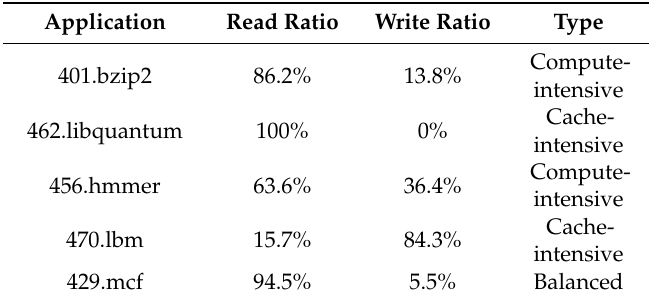
Table 2. The detailed application